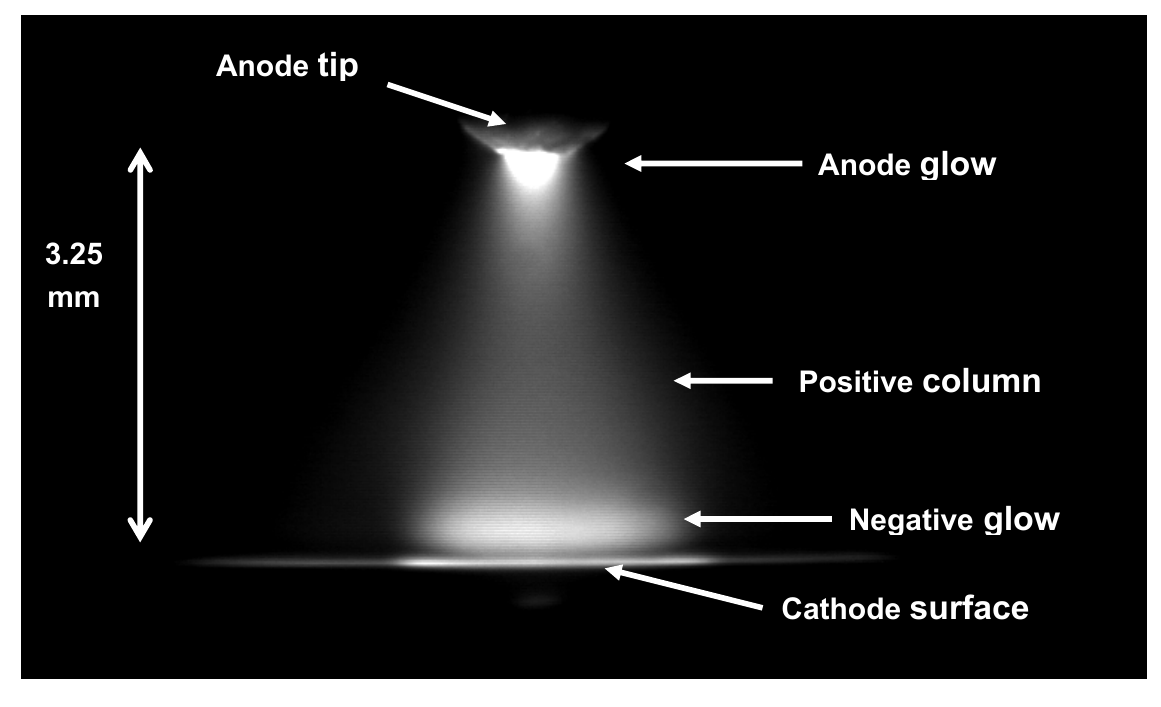
Figure 1. The CCD camera picture of the typical ELCAD plasma operating between the electrolyte cathode and the W anode